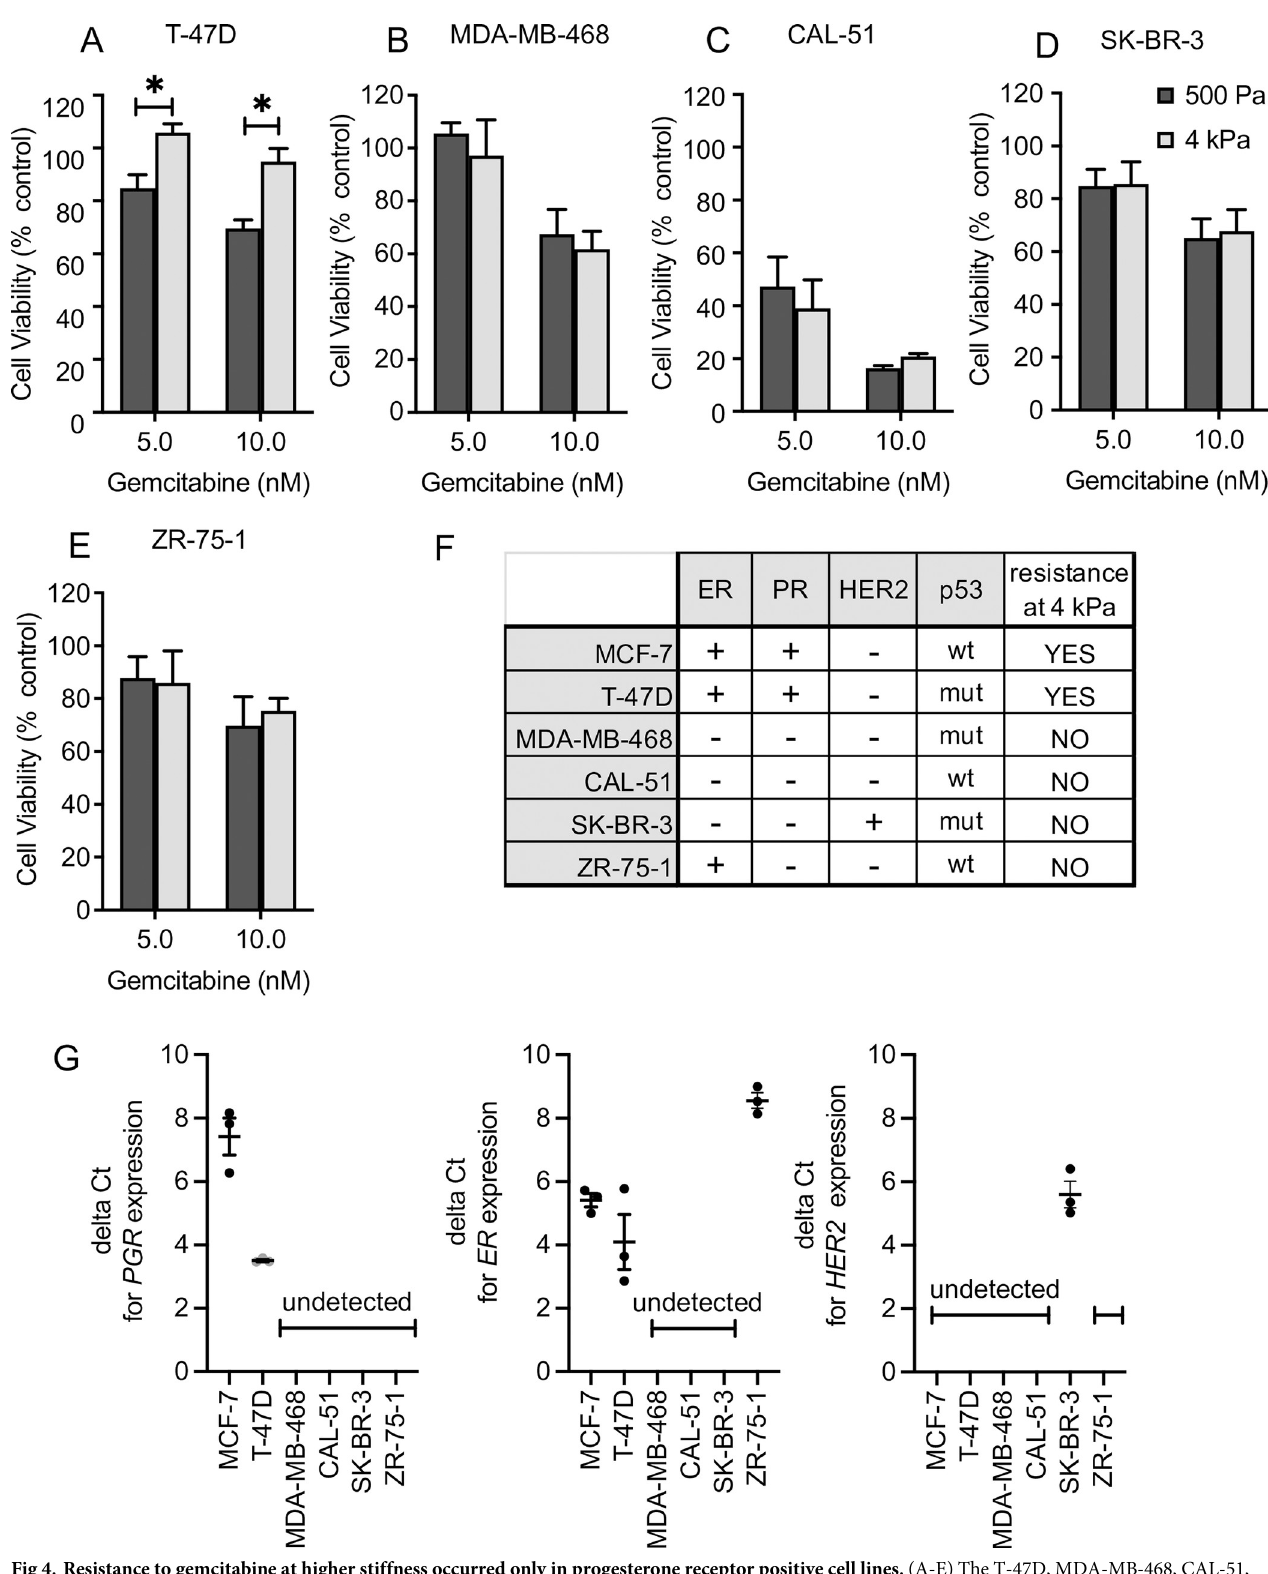
Fig 4. Resistance to gemcitabine at higher stiffness occurred only in progesterone receptor positive cell lines. (A-E) The T-47D, MDA-MB-468, CAL-51, SKBR-3, and ZR-75-1 cell lines were cultured on 500 Pa and 4 kPa stiffness hydrogels for 24 hrs prior to the addition of gemcitabine (gem). After 72 hrs